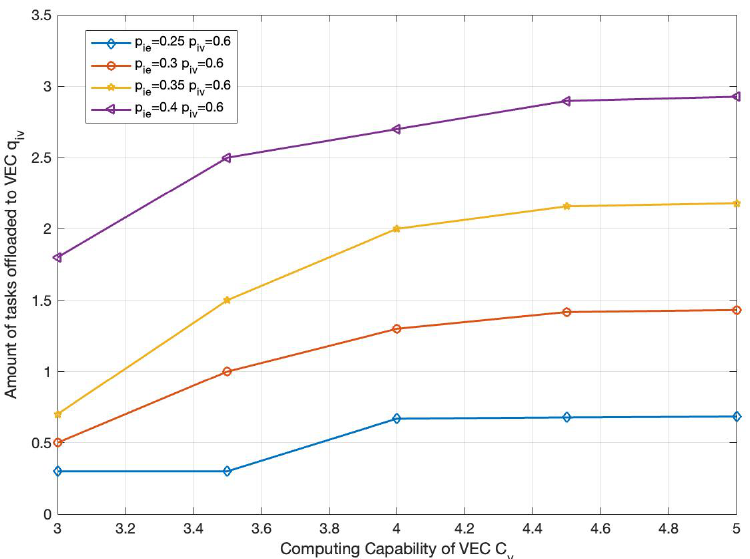
Figure 3. Impact of the processing capability and service price on the